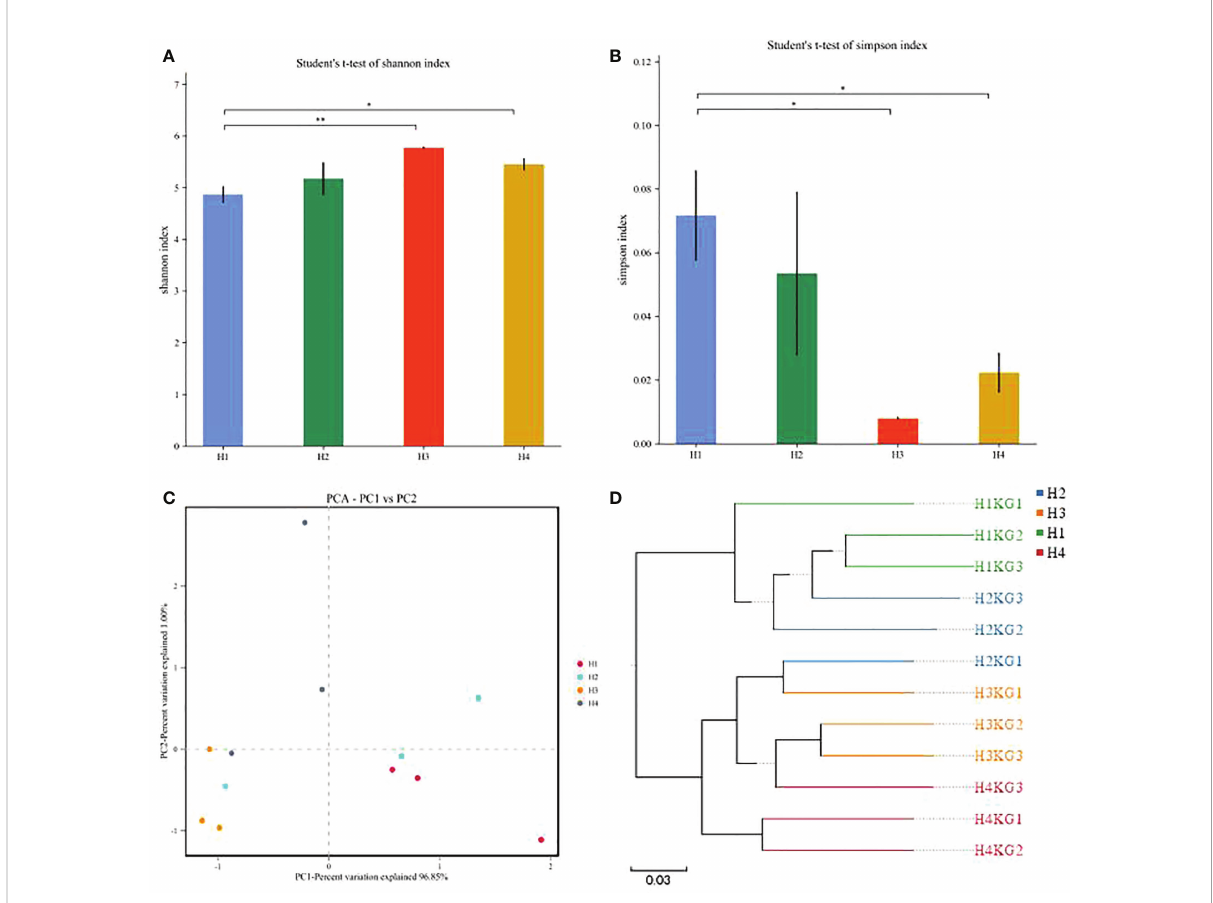
FIGURE 3 The a diversity and b diversity of different height Pennisetum sinese silage bacterial community. The Shannon and Simpson index (A, B) of the silage bacterial community, PCA and UPGMA analysis (C, D) of silage bacterial community. P-values are shown as * P < 0.05, ** P <